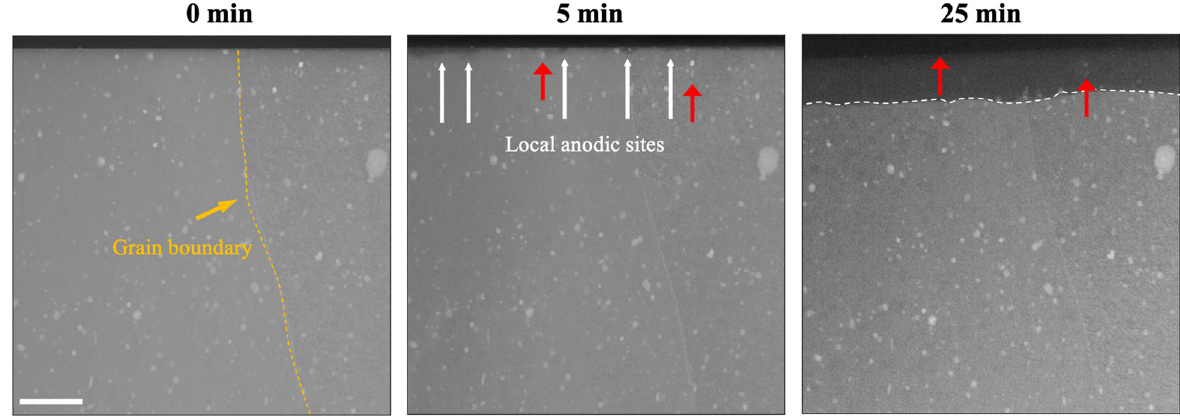
Fig. 3 LP-TEM observations of initial stages of the conversion layer formation in 0.01 M NaCl + 0.01 M Li 2 CO 3 . Time-resolved HAADF-STEM images of a sandwiched specimen, showing initial local anodes and then the subsequent uniform dissolution. The white arrows indicate initial local dissolution sites. The red arrows point to the nanoscopic copper-rich IMP as the potential cathodic sites. The specimen is approximately 300 nm thin excluding the TEOS layers. The scale bar is 1 μ m.